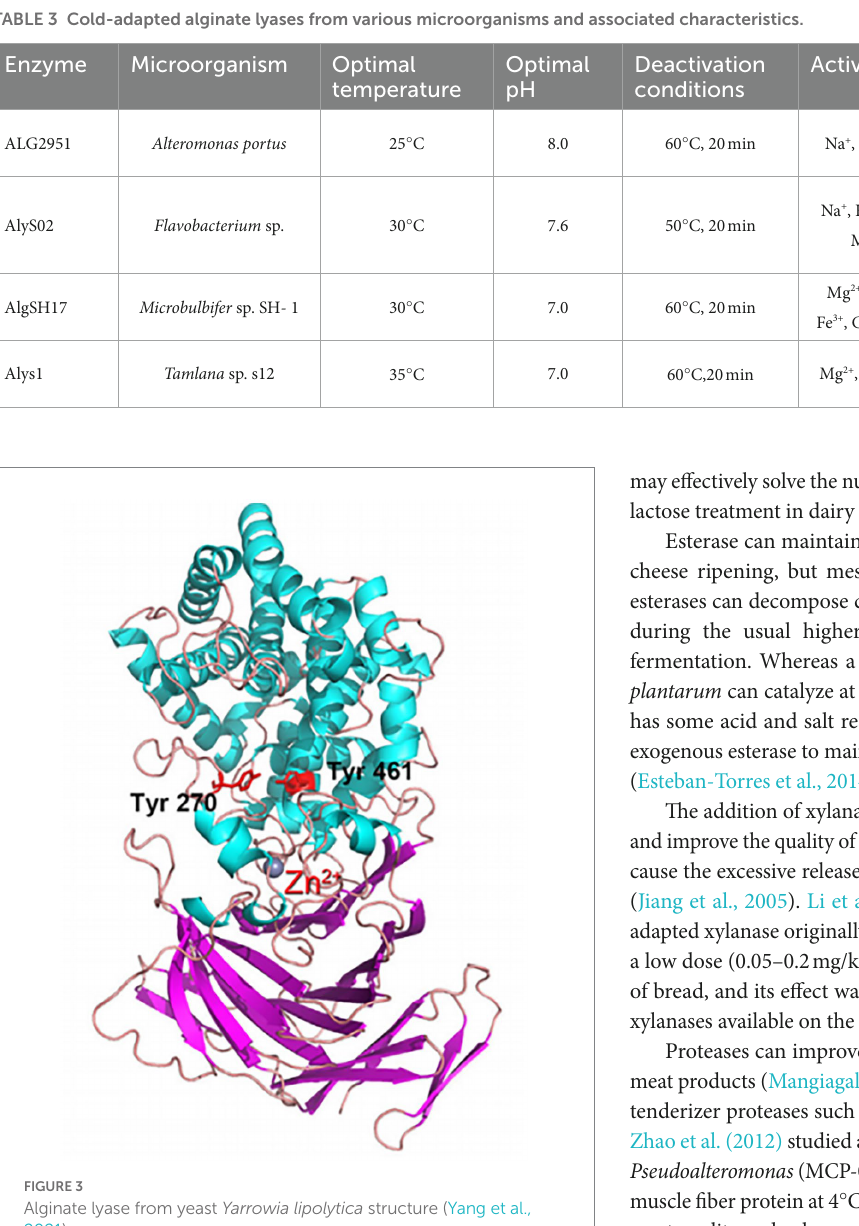
FIGURE 3 Alginate lyase from yeast Yarrowia lipolytica structure (Yang et al.,